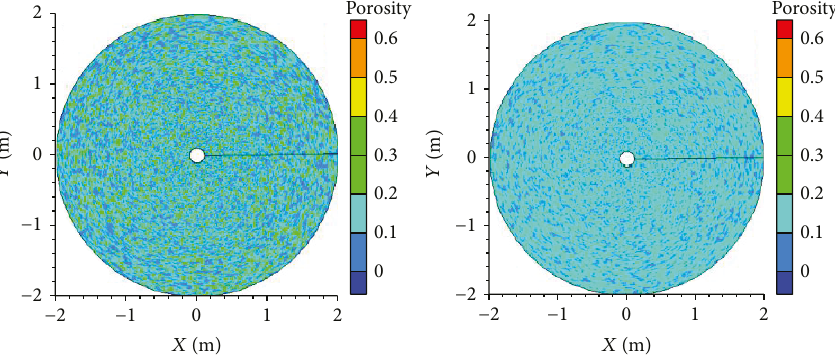
Figure 2: Random porosity distribution.